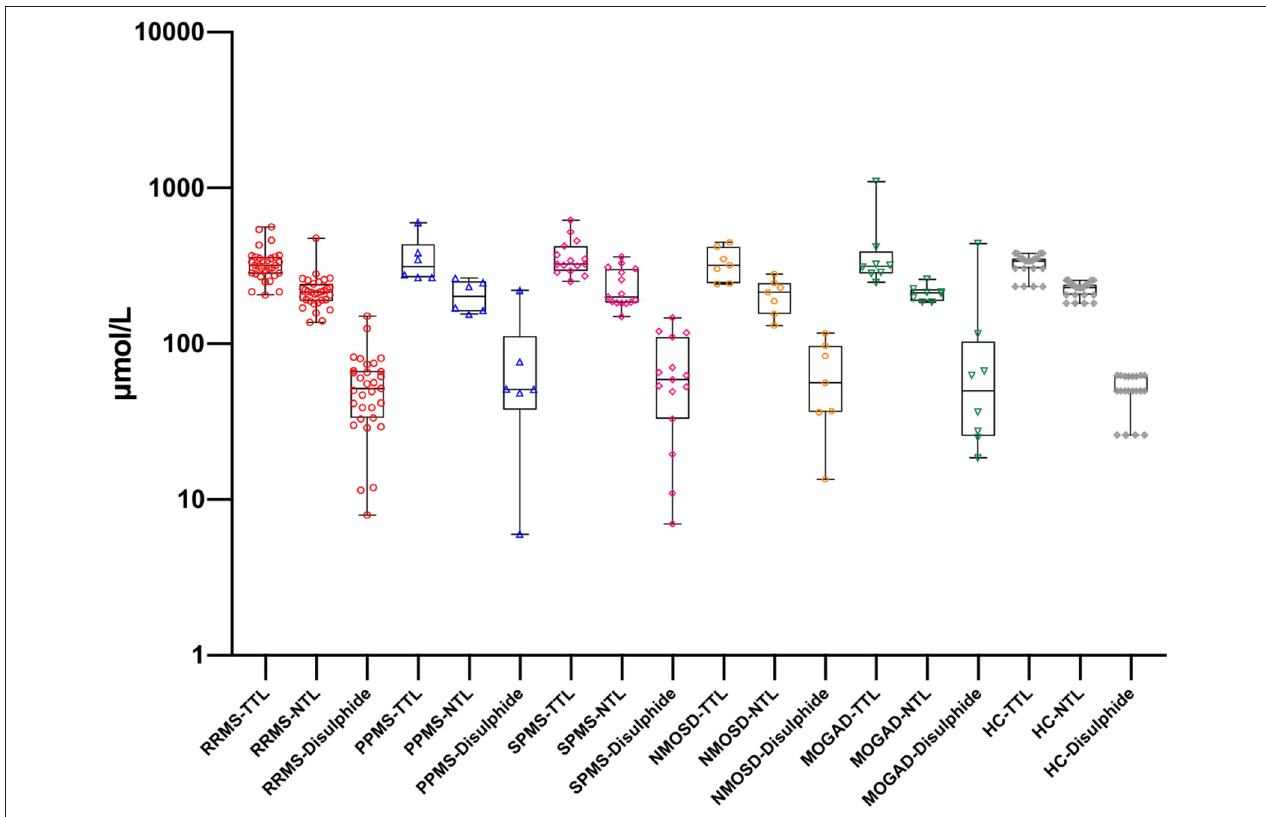
FIGURE 2 | Thiol levels in serum samples with different disease subgroups and healthy controls. RRMS, relapsing-remitting multiple sclerosis; PPMS, primary progressive multiple sclerosis; SPMS, secondary progressive multiple sclerosis; NMOSD, neuromyelitis optica spectrum disorders; MOGAD, myelin oligodendrocyte glycoprotein-Ab-associated disease; HC, healthy control; TTL, total thiol; NTL, native thiol. There is no statistically significant difference for the same biomarker between